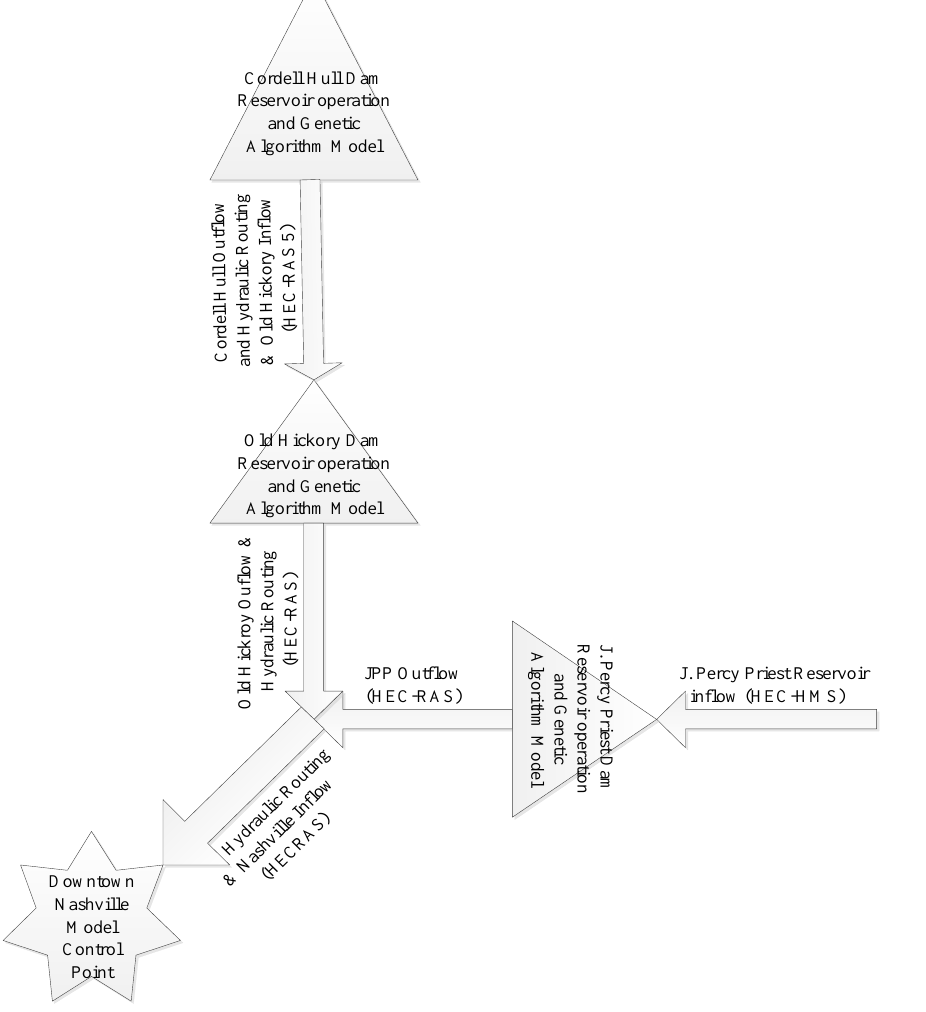
Figure 6. Portion of Cumberland River system modeled using HEC-RAS.